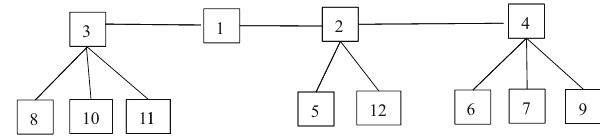
Figure 4: Network structure in W e = W r = W d = 1/3